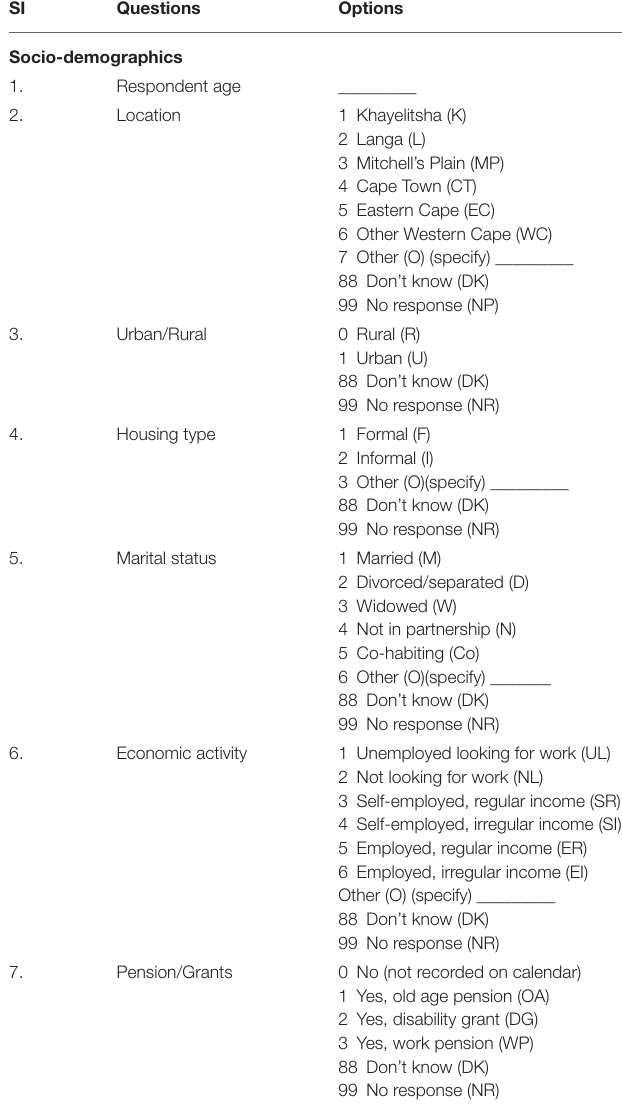
TABLE 1 | Questionnaire related to socio-demographic behavior.